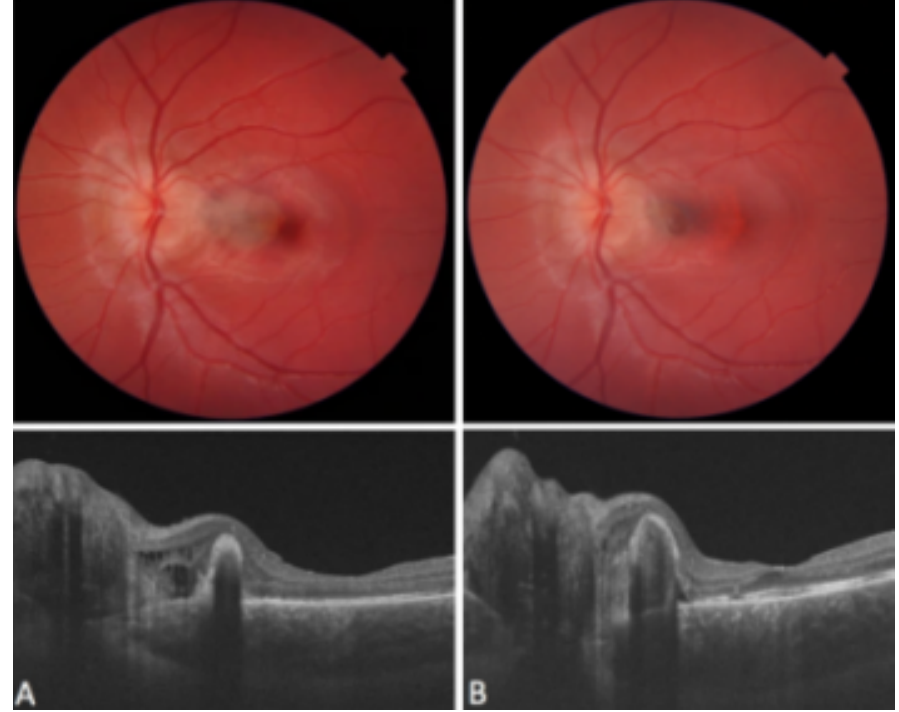
Figure 2: Fundus image and OCT scan A) prior to treatment and B) 12 months after injection. The subretinal hemorrhage and cystoid edema resolved, leaving behind a dissociation of pigment epithelium and a shallow subretinal